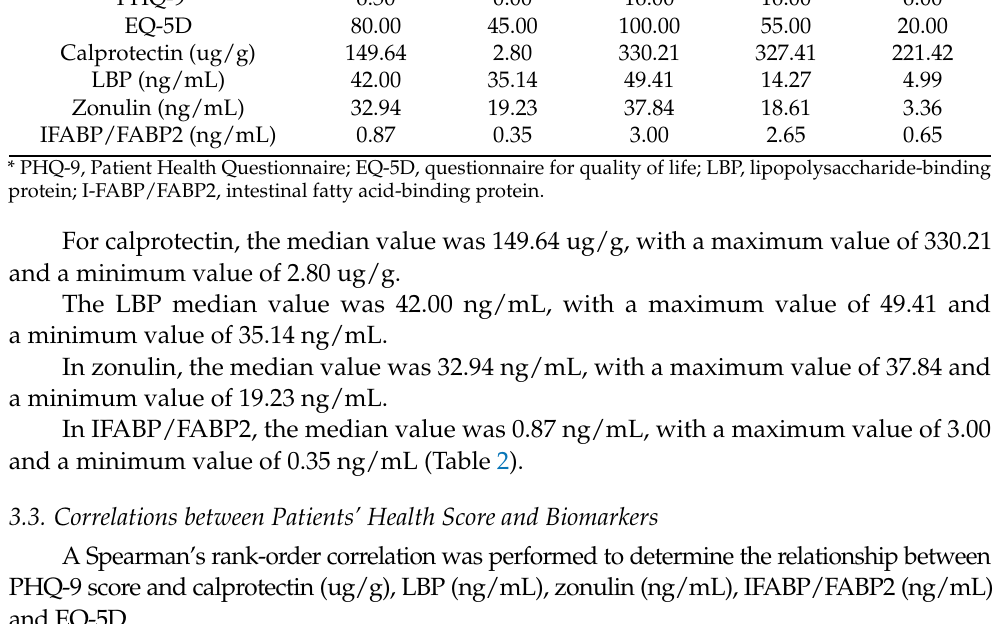
Table 2. Measures of central tendency and dispersion for the numerical variables included in the study.